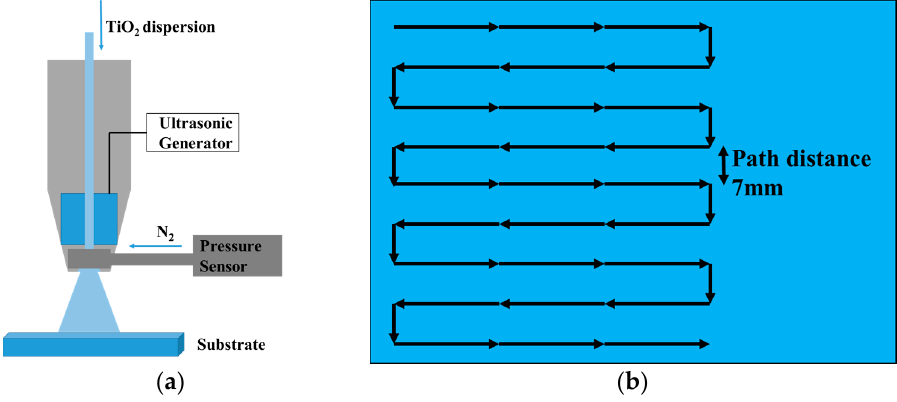
Figure 1. Schematic representation of ( a ) setup for the spray coater and ( b ) the spray nozzle moving path.